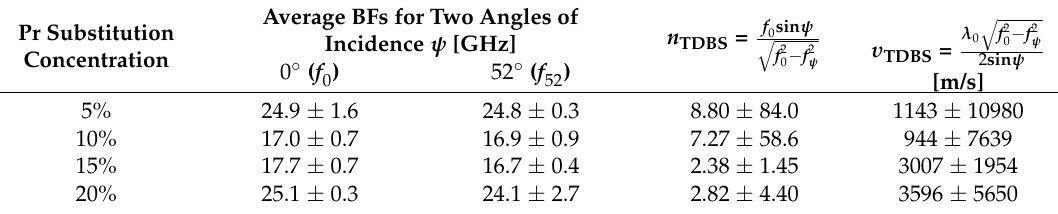
Table 1. Average Brillouin frequency (BF) values measured for two angles of incidence, ψ = 0 ◦ and ψ = 52 ◦ for the different concentration of Pr substitution in the (Bi 1 − x Pr x )(Fe 0.95 Mn 0.05 )O 3 thin films deposited on Si. The calculated optical indices ( n TDBS ) and acoustic velocity ( ν TDBS ) using the measured BFs are also